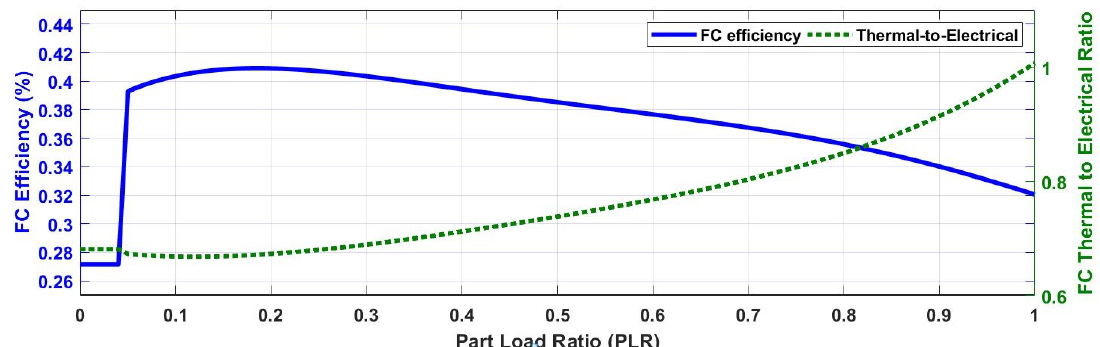
Figure 2. Fuel cell efficiency and thermal to electrical ratio as function of Part Load